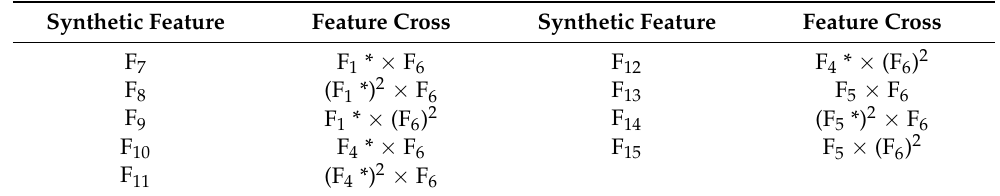
Table 3. Synthetic features of the feature crosses.